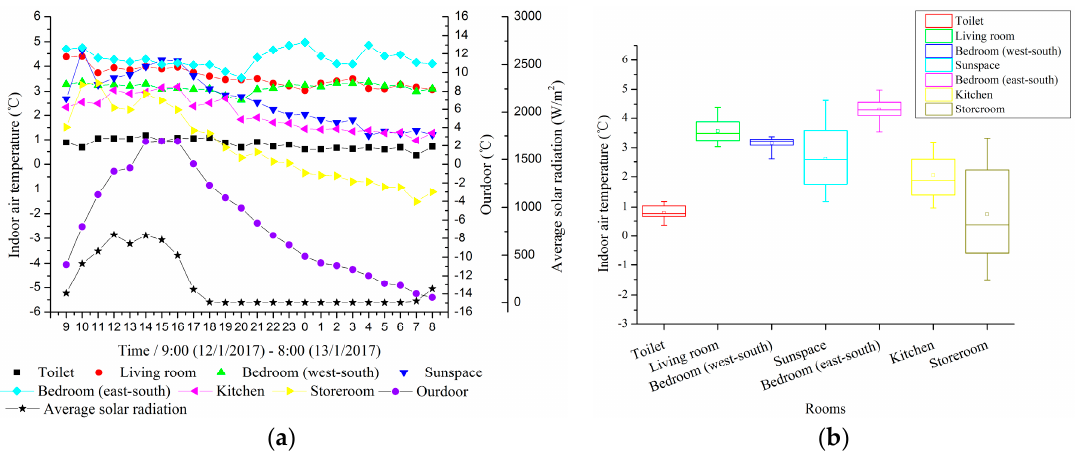
Figure 4. Average air temperature of each room (reference condition); ( a ) Hourly average temperature variation; ( b ) Hourly average temperature histogram. Table 4. Average air temperature of each room with difference conditions.